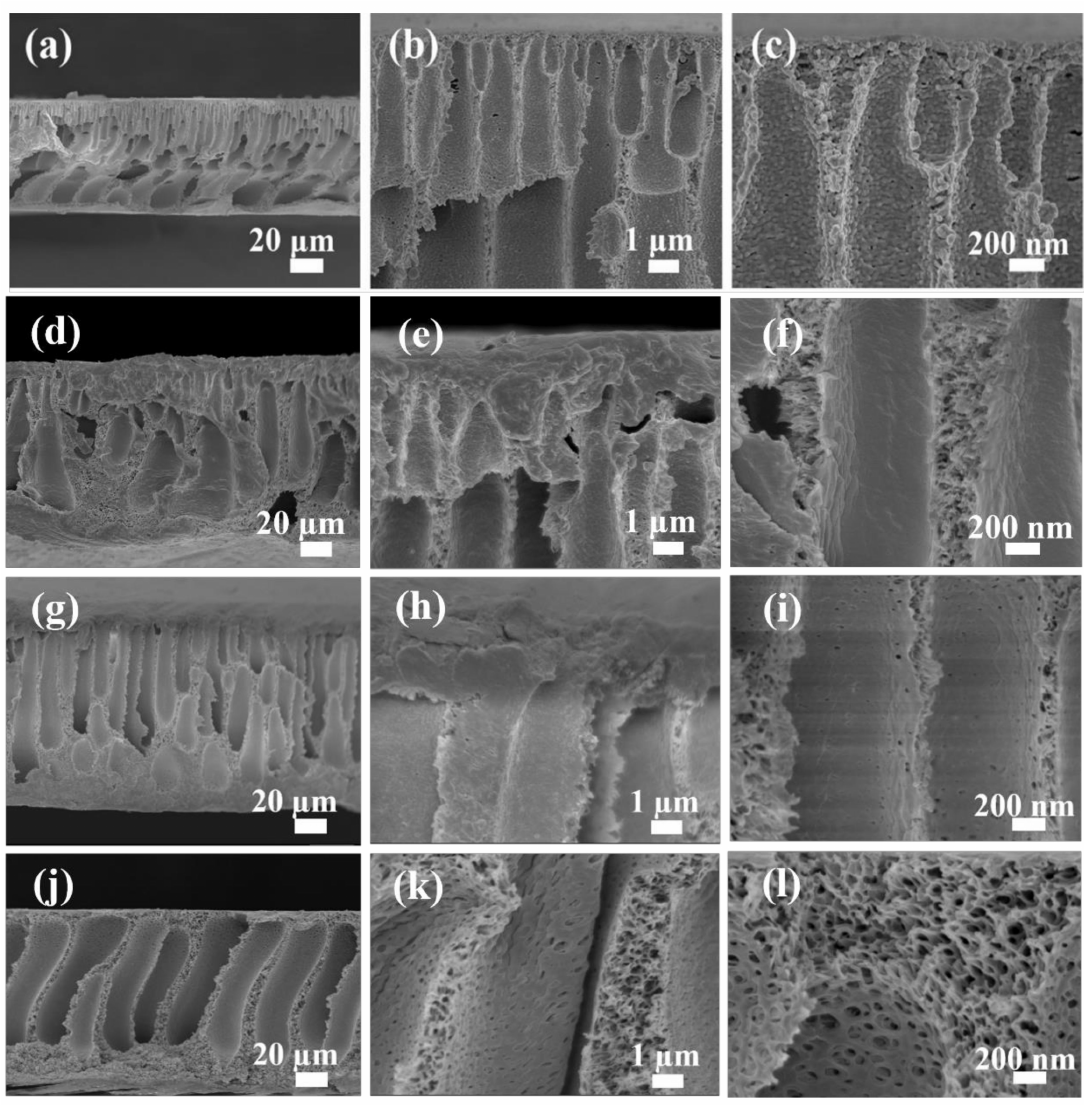
Figure 4. SEM images of cross-sectional views of ( a – c ) M-PES, ( d – f ) M-PES/Au-HET-2, ( g – i ) M- PES/Au-HET-3, and ( j – l )